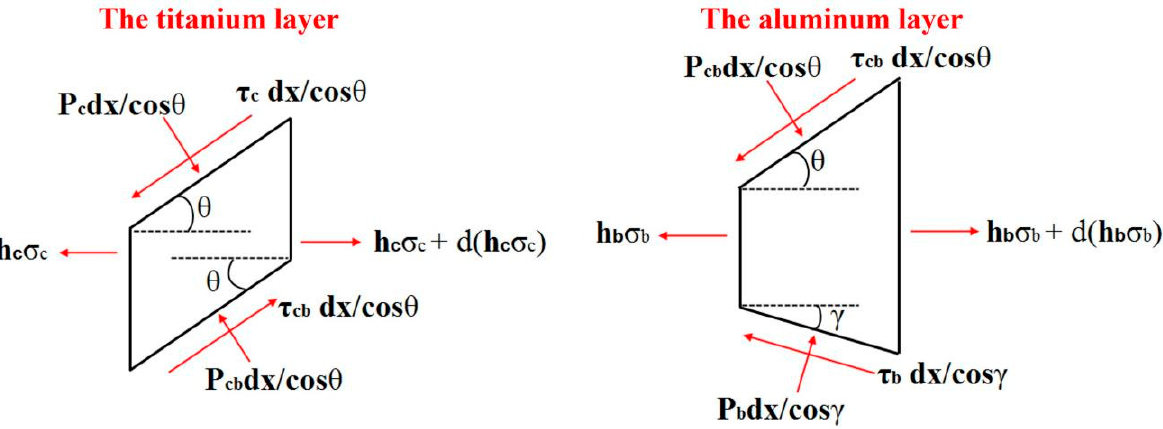
Figure 2. Stress state of micro-element in region I.